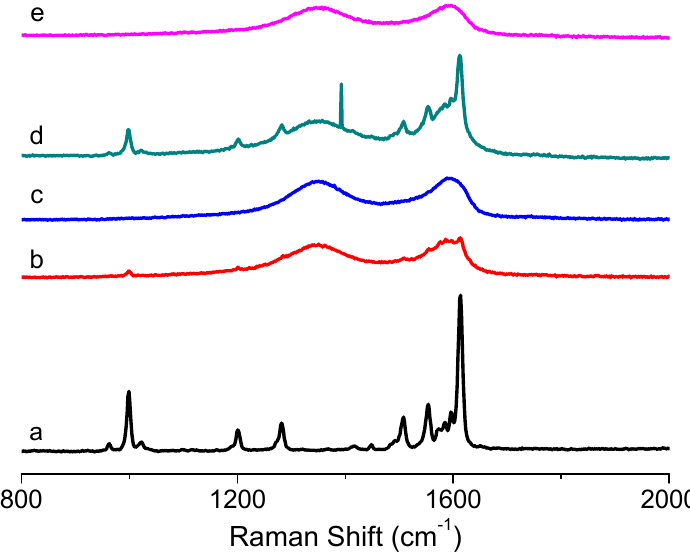
Figure 8. Raman spectra of ( a ) PBD, ( b – d ) PBD:GO composites with chemical components of weight ratio 2:1, 5:1 and 10:1 (w/w), respectively, ( e ) GO.